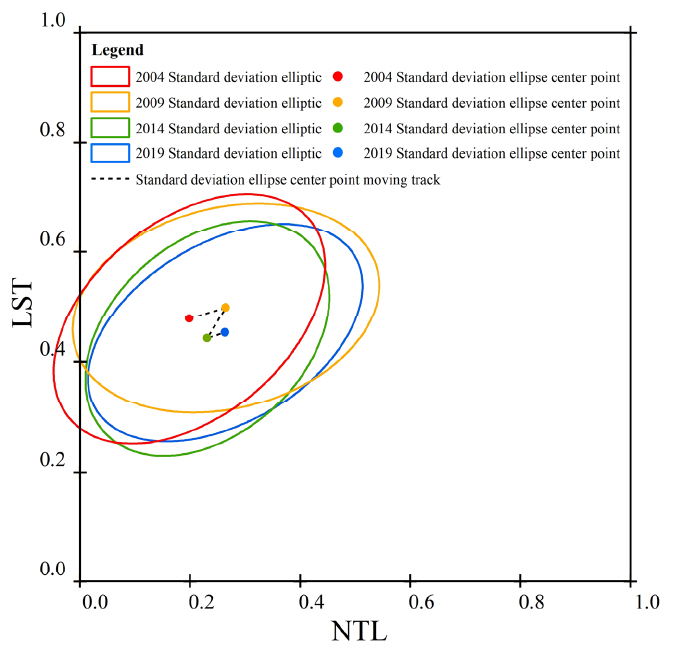
Figure 8. Spatial characteristics of the standard deviation ellipses of the NTL and LST within the sixth ring road of Beijing from 2004 to